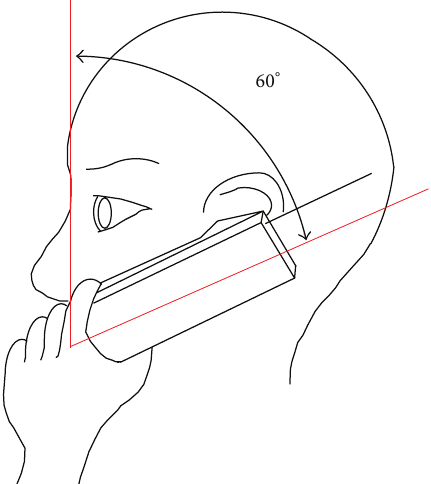
Figure 3: Typical inclination angle of handy phone while